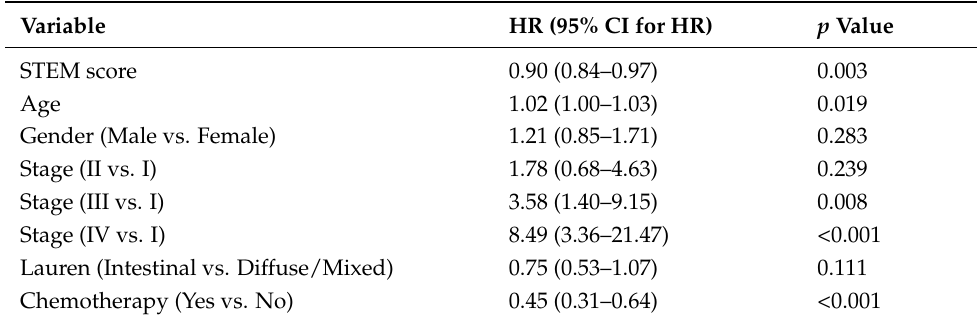
Table 3. Multivariate Cox regression analysis used to evaluate the independent risk factor of progno- sis in the training cohort.